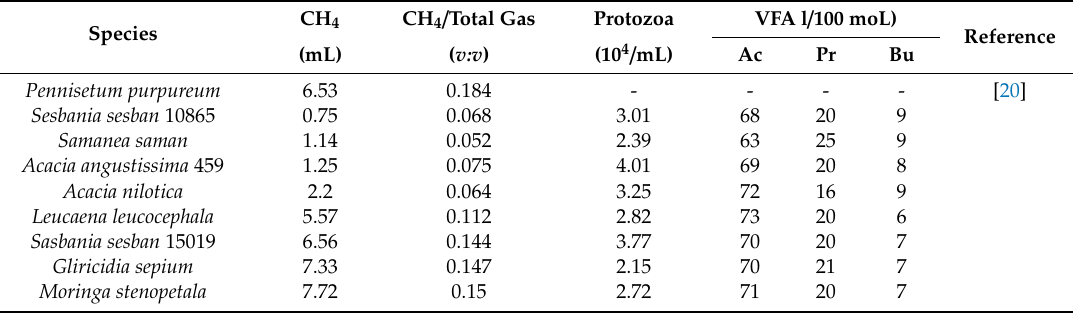
Table 3. Potential of foliage of tropical trees for methane (CH 4 ) mitigation, rumen defaunation, and changes in the molar proportions of volatile fatty acids in vitro.